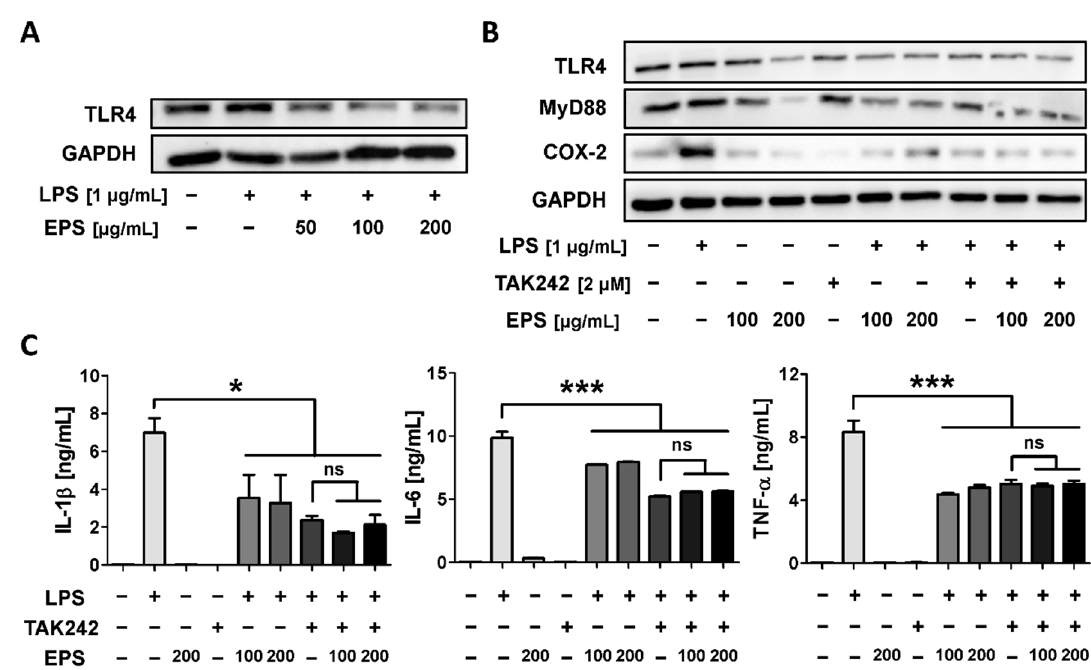
Figure 7. EPS inhibited LPS-induced inflammatory response through Toll-like receptor 4 (TLR4) pathway in RAW 264.7 cells. ( A ) EPS inhibited the expression of TLR4 induced by LPS. ( B ) The expression levels of TLR4, Myeloid differentiation factor (MyD88), and COX-2 in the EPS-pretreated groups were analyzed using TAK-242; expression levels of TLR4 and MyD88 were inhibited by EPS in LPS-treated groups similar to the TAK-242-treated group; COX-2 was inhibited by TAK-242 and EPS to a similar level. ( C ) EPS and TAK-242 suppressed the expression of proinflammatory cytokines induced by LPS. However, there was no synergetic effect observed when EPS and TAK-242 were simultaneously administered to RAW 264.7 cells. * p < 0.05 and *** p < 0.001 versus the LPS-treated group; ns, not significant.